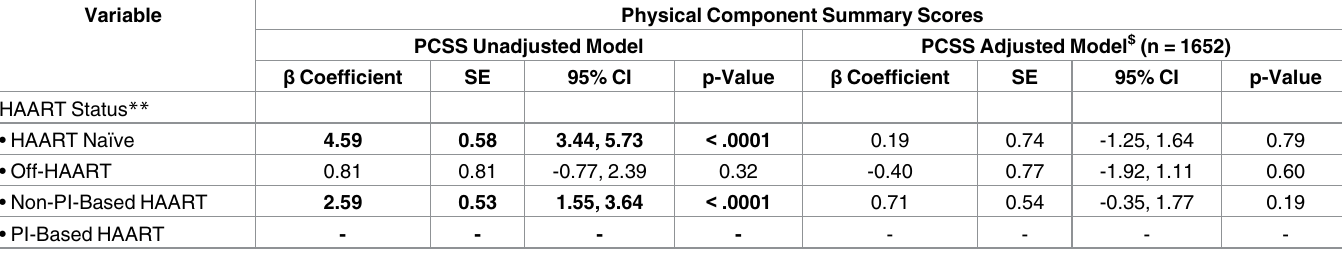
Table 4. Unadjusted and adjusted MCS scores for HAART with PI-HAART as the referent category.